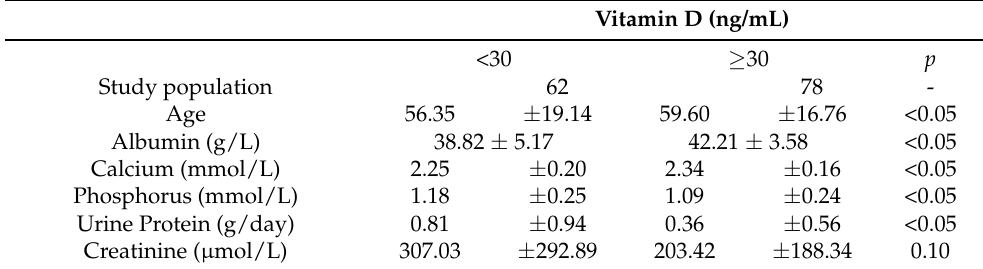
Table 5. Sufficient vs. not sufficient (insufficiency and deficiency) vitamin D levels compared to other variables in chronic kidney disease